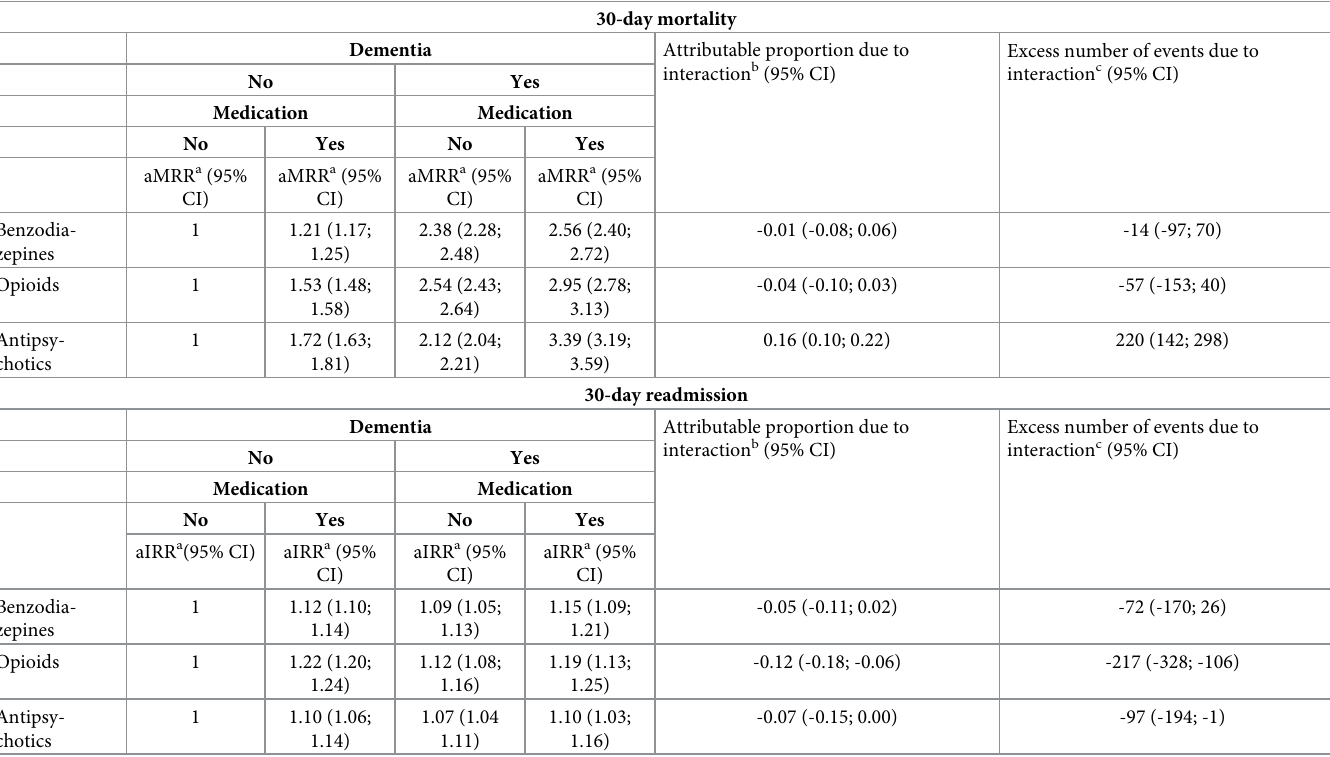
Table 3. Adjusted mortality rate ratios (aMRRs) for the risk of 30-day mortality and adjusted incidence rate ratios (aIRRs) for the risk of 30-day readmission in pneumonia patients with dementia (without medication use), with use of benzodiazepines, opioids or antipsychotics (without dementia), or with both, compared with those with neither exposure in 298,872